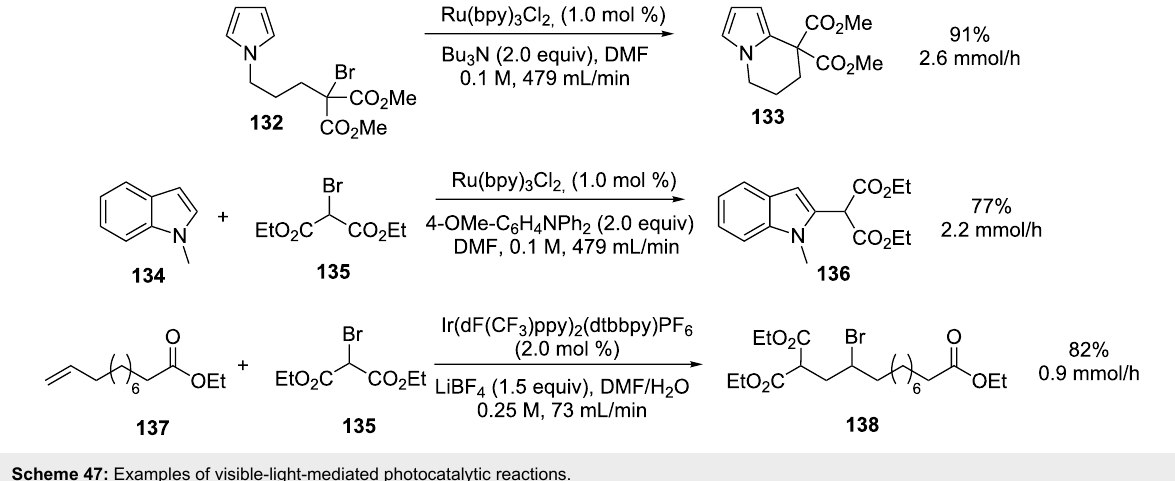
mediated generation of the Vilsmeier reagent by using Ru(bpy) 3 2+ and CBr 4 in DMF (Scheme 48)